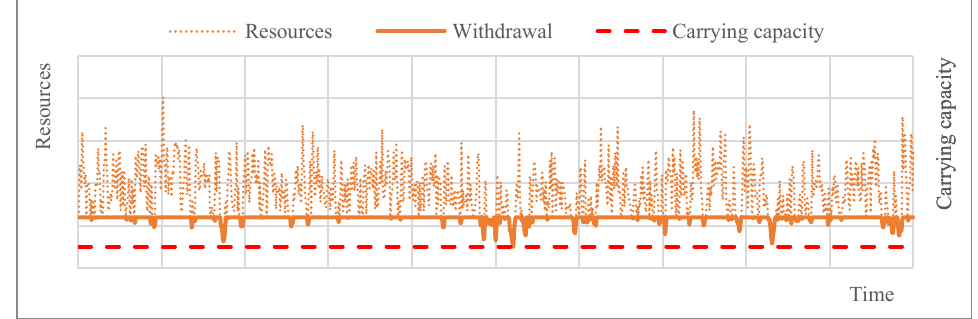
Figure 5. Toy model: The concept of storage with HK dynamics. Red dash line shows the carrying capacity of the population.